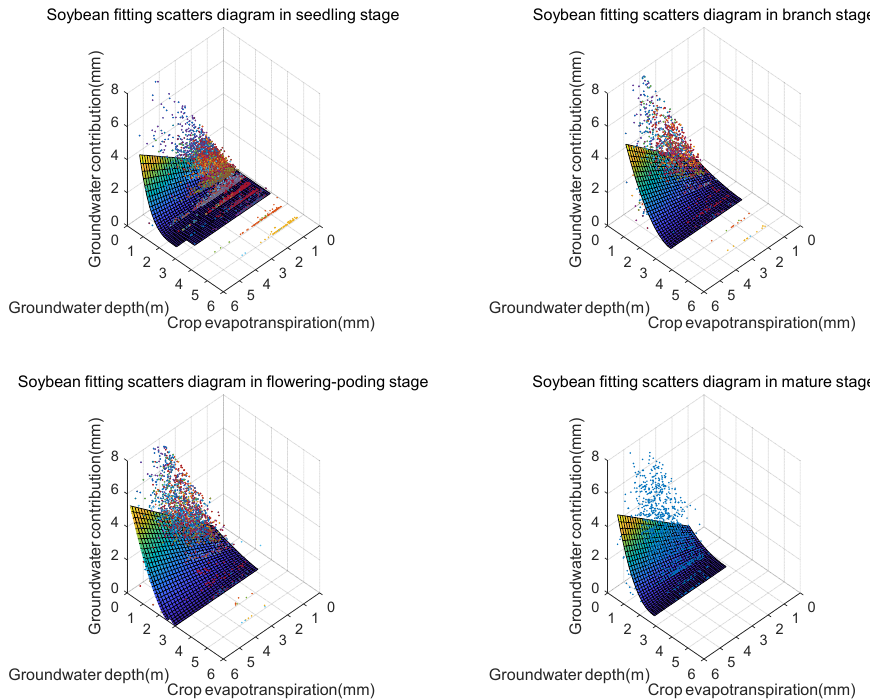
Figure 8. Fitting scatter diagrams for groundwater depth, crop evapotranspiration, and groundwater contribution in each growth period for soybeans using the Aviriyanover formula method.